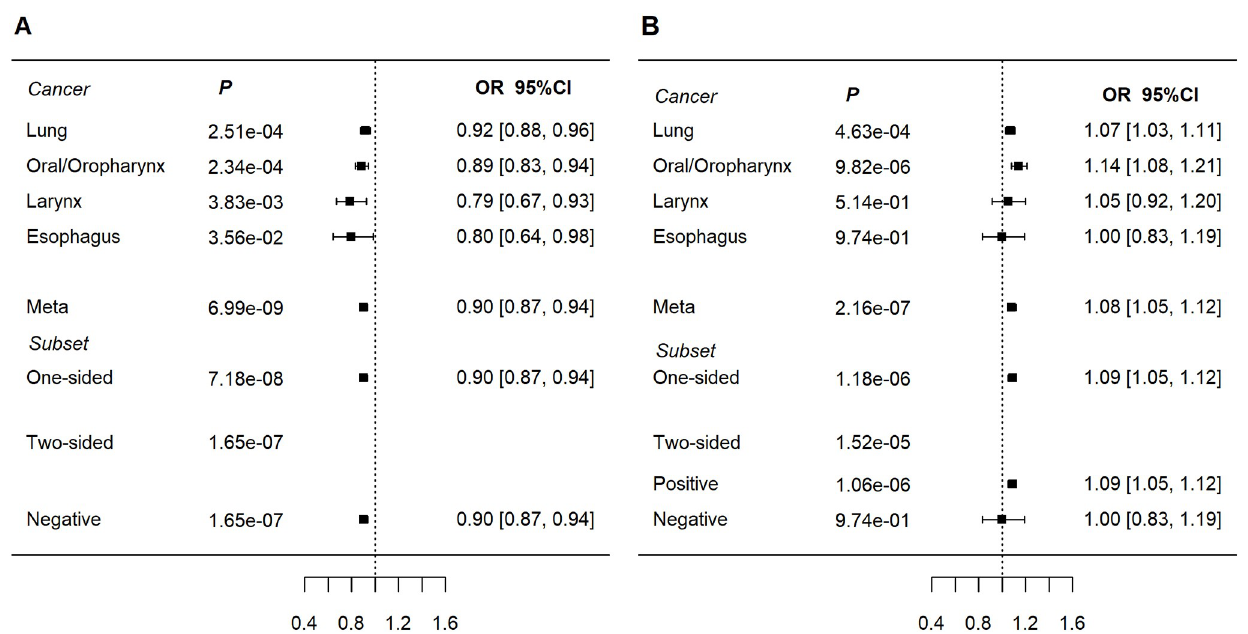
Fig 2. Forest plots of ORs for new aerodigestive SqCC-related loci. a) rs56321285 at 2q33.1 ( TMEM23 ). Subset refers to subset based meta-analyses (ASSET). b) rs12133735 at 1q32.1 (near